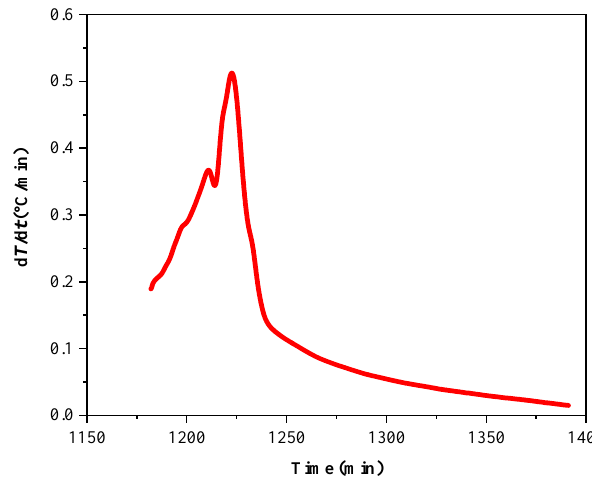
Figure 7. Temperature rise rate time curve of LP30 + PFPN.